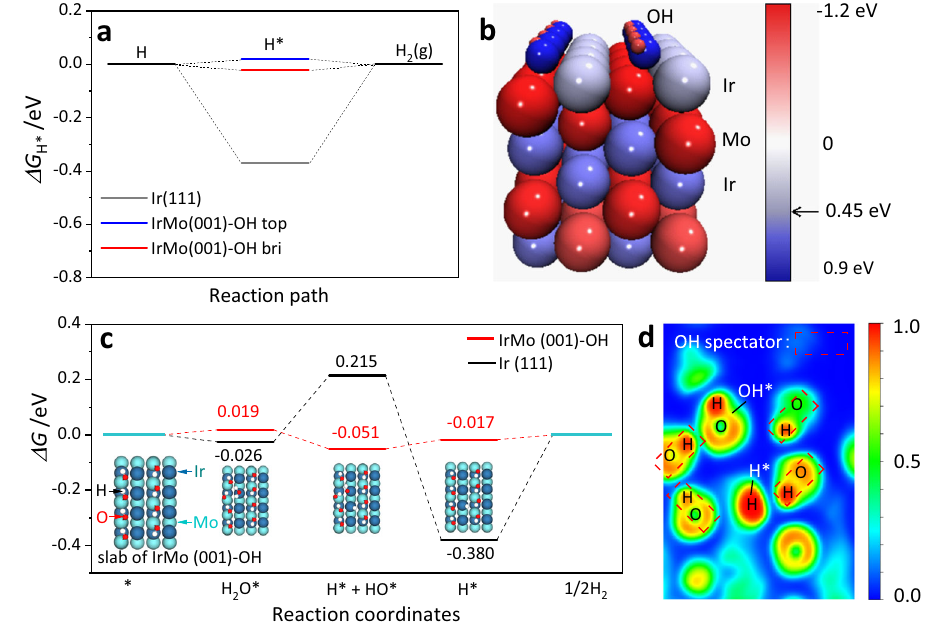
Fig. 6 | HER mechanism analysis. a Gibbs free energy diagram for HER reaction through Volmer – Tafel reaction. Slab of IrMo-OH exhibits two types of the stable adsorptioncon fi guration,includingthetopandbridgecon fi gurationatIr. b Color- patched graph of Bader chargefor IrMo (001)-OH slab, the arrow-marked position